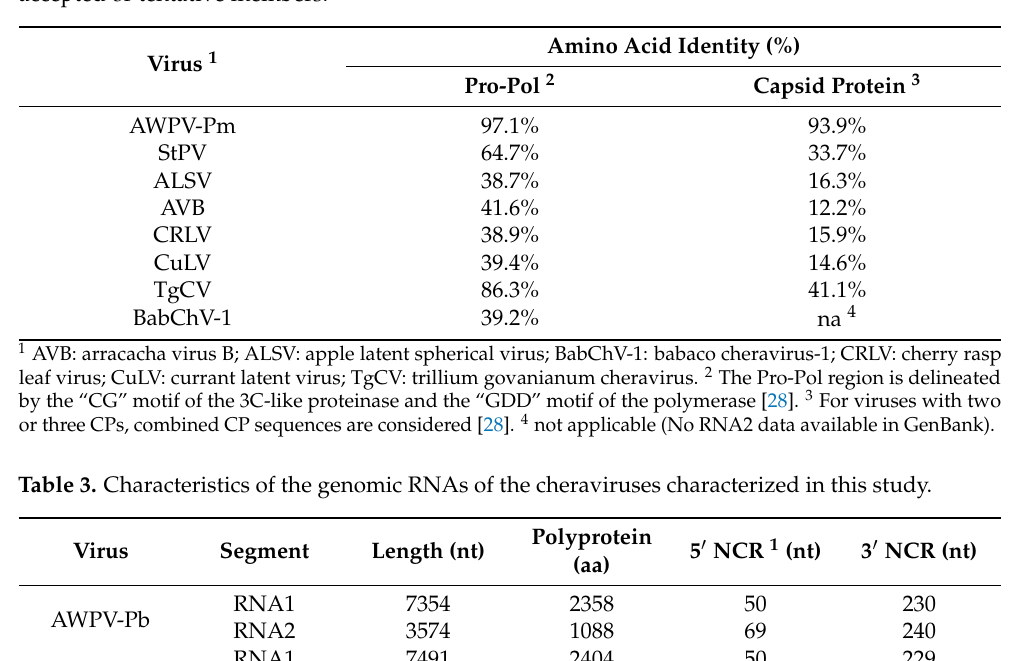
Table 2. Percentages of identity observed between the Pro-Pol region and the capsid protein region of alpine wild prunus virus- P. brigantina (AWPV-Pb) and the corresponding proteins of Cheravirus accepted or tentative